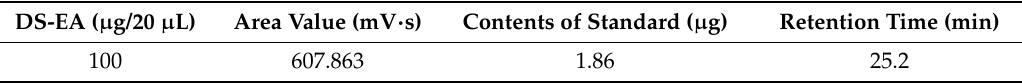
Table 2. HPLC quantitative analysis results of Dianthus superbus -EtOAc soluble fraction (DS-EA).